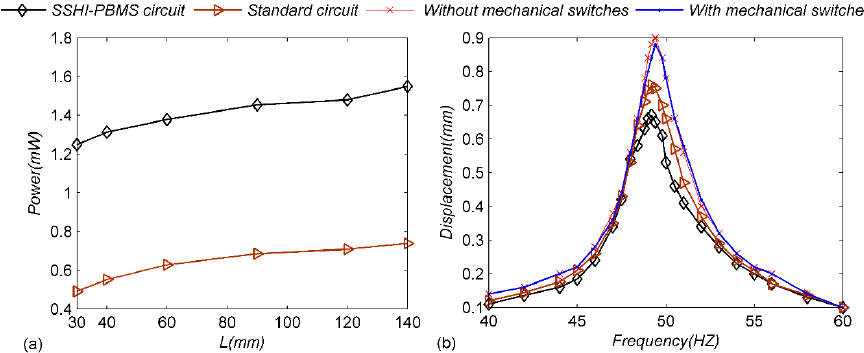
Figure 11. ( a ) Power responses of the SSHI-PBMS circuit and the standard circuit; ( b ) Displacement responses of the generator for different situations.